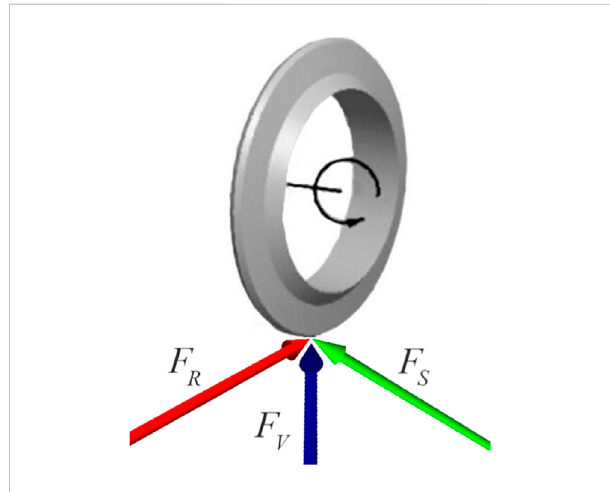
FIGURE 3 Force diagram of the disc cutter during rock-breaking process.